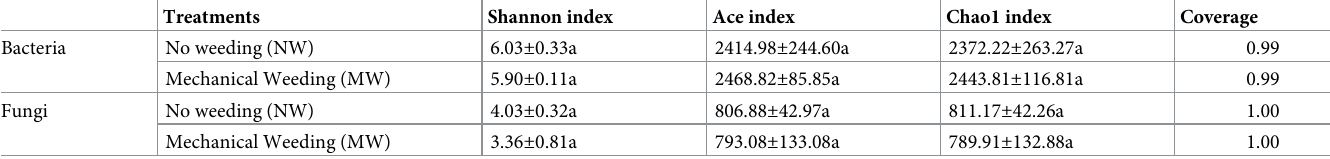
Table 3. Alpha diversity index of soil bacteria and fungi in star anise plantations between the NW and MW treatments (OTU level). Treatments